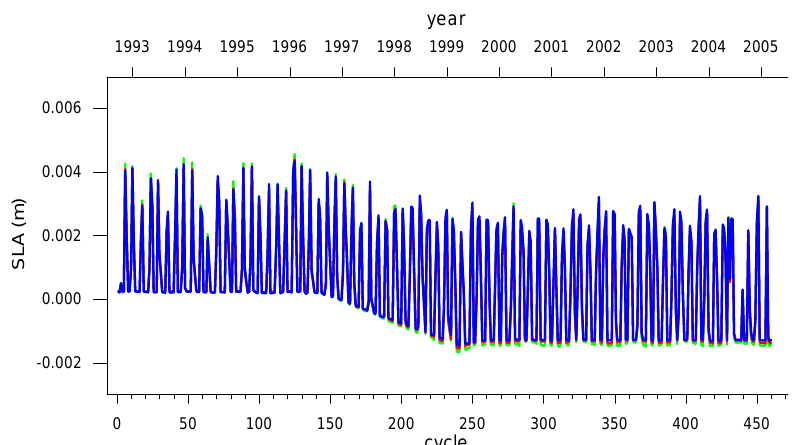
Figure 6. SLA differences DataSet1-DataSet3 (different wet_cor models: Scharroo - Ruf). blue - Tropical; red : Sub-Tropical; green: